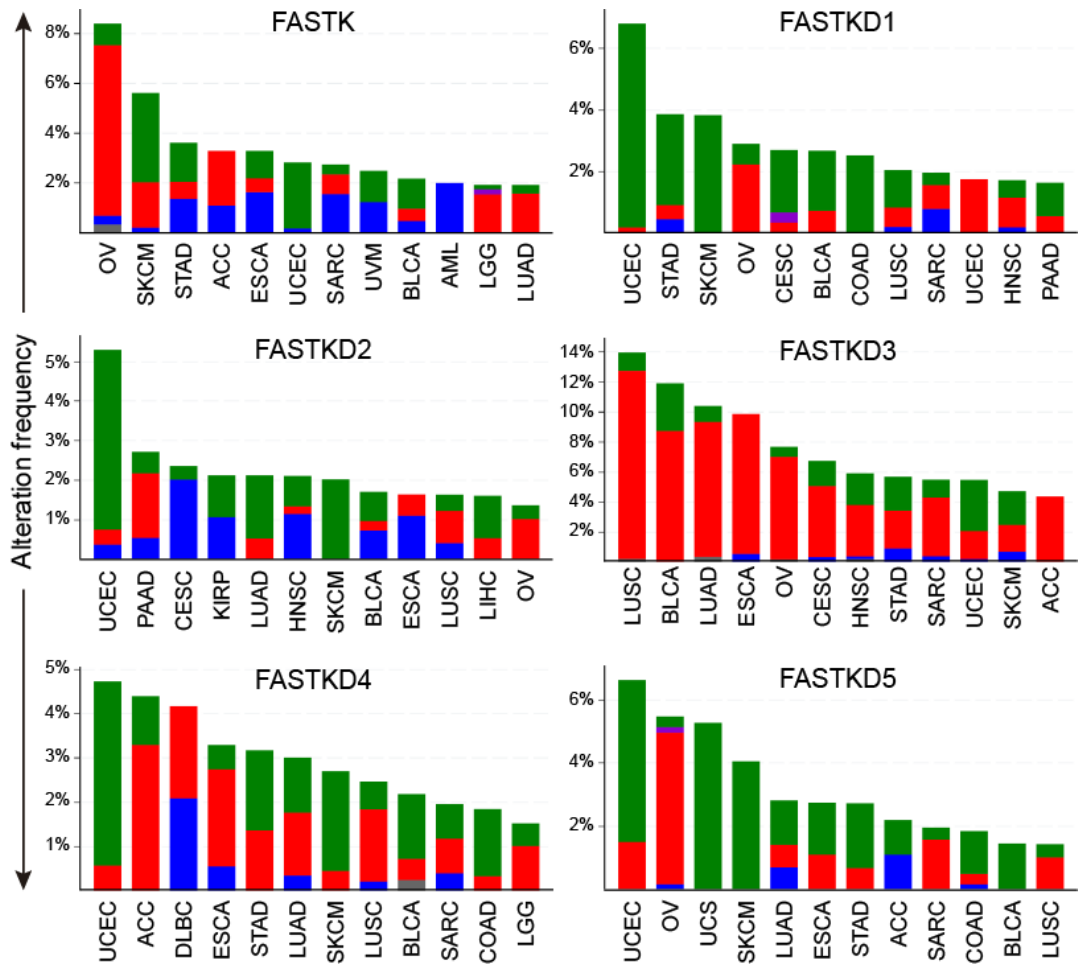
Figure 1. Alterations of the FASTK gene family in cancer. Distribution of the genomic alterations of each member of the FASTK family across the 12 tumor types harboring the highest alteration rates. Frequencies in tumors not shown are provided in Table S2. Colors represent different types of alterations: red-amplification, green-mutation, blue-deletion, purple-fusion and grey-multiple alterations. Figures were generated with the cBioPortal online